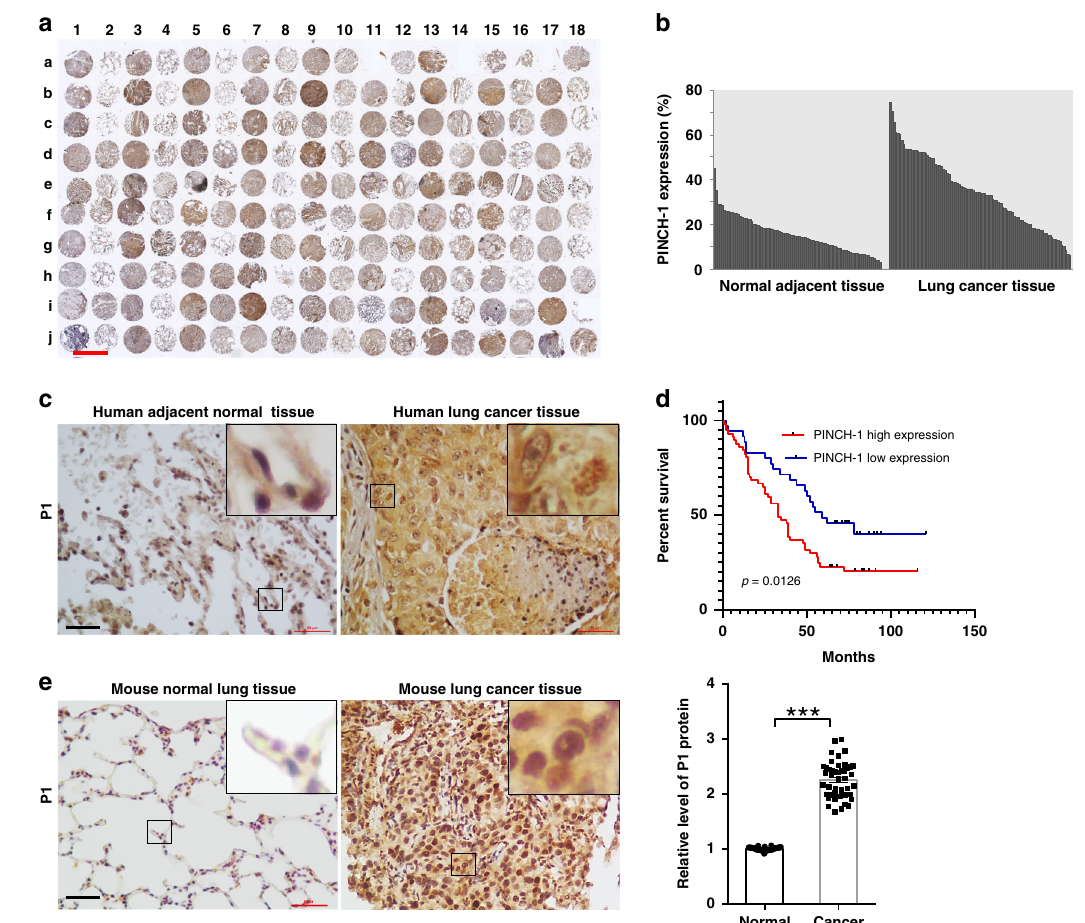
Fig. 1 PINCH-1 level is increased in lung adenocarcinoma. a , b Human lung adenocarcinoma tissues and adjacent normal tissues from a microarray were stained with anti-PINCH-1 (P1) antibody ( a ). The samples in columns 1, 3, 5, 7, 9, 11, 13, 15, and 17 on rows a – i and columns 1, 3, 5, 7, 9, 11, and 13 – 18 on row j were derived from lung adenocarcinoma tissues. All other samples were derived from adjacent normal tissues. Bar = 1 mm. The mean intensities (arbitrary units) of PINCH-1 staining from lung adenocarcinoma tissues ( n = 93) and normal adjacent tissues ( n = 87) were quanti fi ed ( b ). c Higher magni fi cation images of representative IHC staining shown in panel a obtained with anti-PINCH-1 antibody (brown) and haematoxylin counterstain (blue). Bar = 20 μ m. The boxed areas in the IHC staining were enlarged and shown in the upper right corner. d Kaplan – Meier survival curve of 90 lung adenocarcinoma patients. Patients were divided into two groups according to the mean intensities of PINCH-1 staining in cancer tissues of the tissue array (high expression: n = 57, low expression: n = 35, Log-rank (Mantel – Cox) test was used for the statistical analysis). e Lung adenocarcinoma was induced by administration of Ad-Cre into the lung of Kras LSL − G12D/ + mice. Sixteen weeks later, sections from the Kras LSL − G12D/ + mice administrated with Ad-Cre or without Ad-Cre as a control were analyzed by immunostaining with anti-PINCH-1 antibody. Bar = 20 μ m. The boxed areas in the IHC staining were enlarged and shown in the upper right corner. The mean intensities of PINCH-1 staining in lung adenocarcinoma were quanti fi ed and compared to those of normal lung tissue (normalized to 1; normal group n = 36 fi elds from 6 mice, cancer group n = 49 fi elds from 6 mice; P < 0.0001) (e, right panel). Data in e represent mean ± SEM. Statistical signi fi cance was calculated using two-tailed unpaired Student ’ s t -test, *** P < 0.001. Source data are provided as a Source Data fi